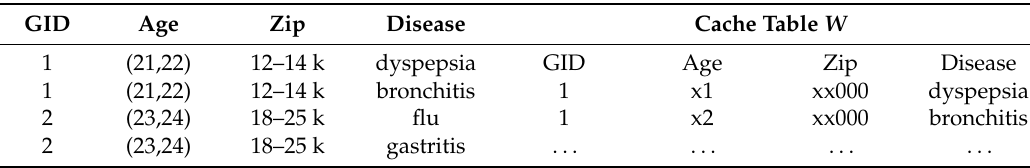
Table 3. The original equivalent group and the cache table W.